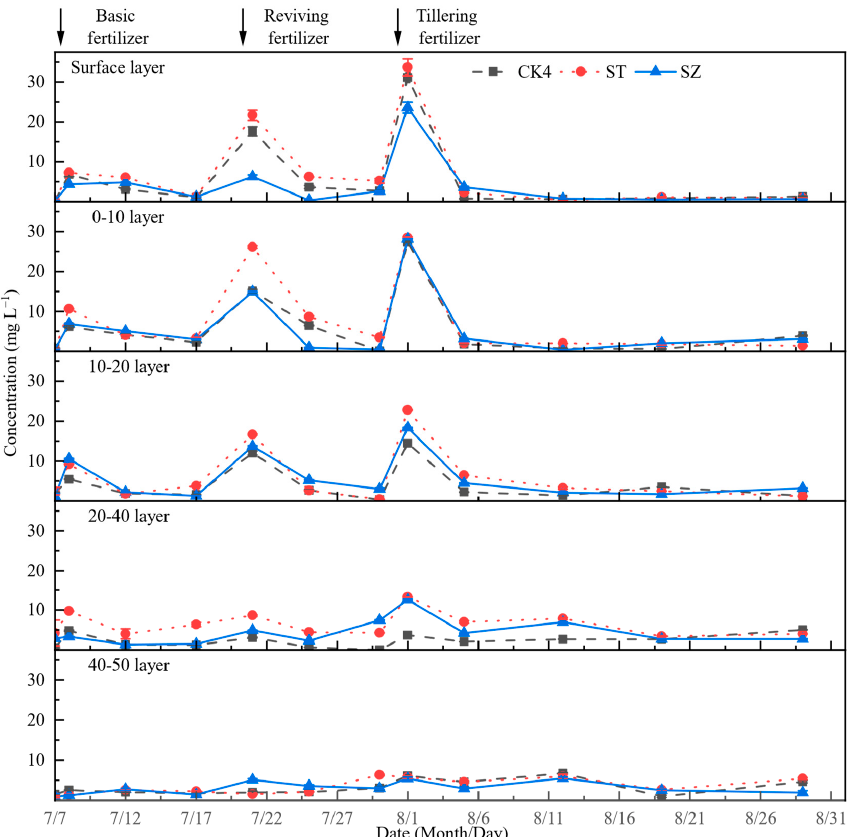
Figure 7. Dynamic changes in ammonia nitrogen (NH 4+ -N) concentration in different layers (in cm) of surface water and soil solutions under different treatments. Black squares indicate no straw returning (CK4); red circles indicate straw returning (ST); blue triangles indicate straw returning with zeolite (SZ). Different fertilizer treatments are indicated by black arrows.